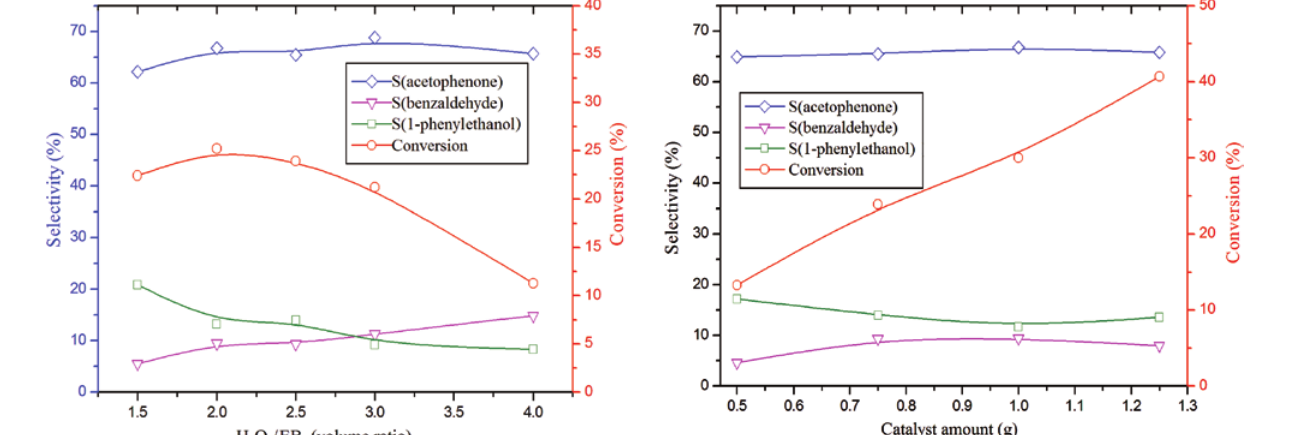
O /ethylbenzene) volume 2 2